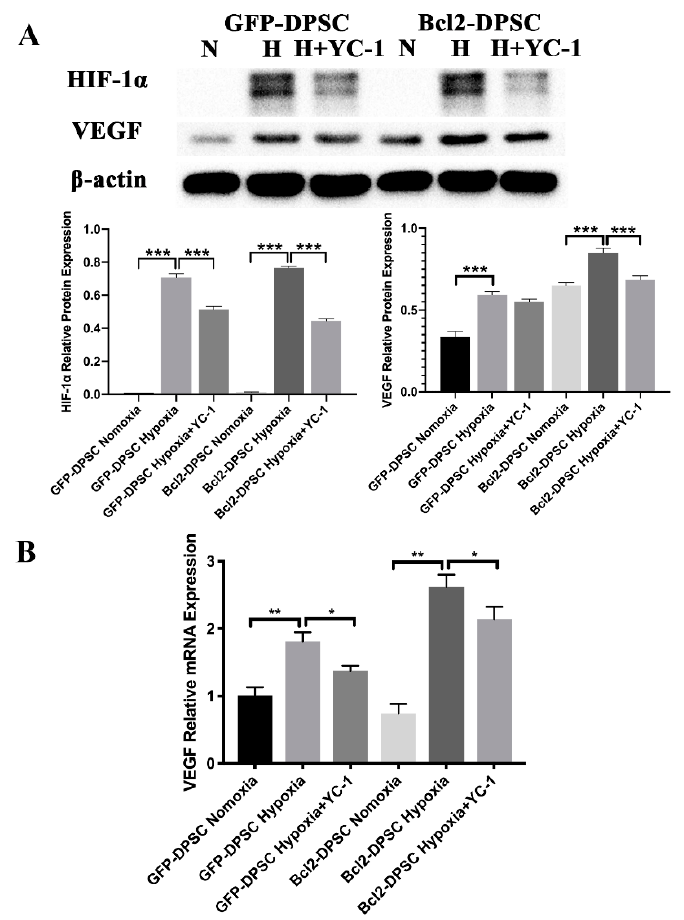
Figure 7. Role of HIF-1 α in VEGF expression in Bcl-2-DPSCs under hypoxia. ( A ) Expression of protein levels of VEGF and HIF-1 α in GFP-DPSCs and Bcl-2-DPSCs under normoxia (N), hypoxia (H), and YC-1 treatment as shown by western blotting. ( B ) Relative mRNA expression levels of VEGF in GFP-DPSCs and Bcl-2-DPSCs under normoxia (N), hypoxia (H), and YC-1 treatment as shown by qRT-PCR assay. β -actin – endogenous control * p < 0.05, ** p < 0.01 *** p < 0.001 versus the corresponding